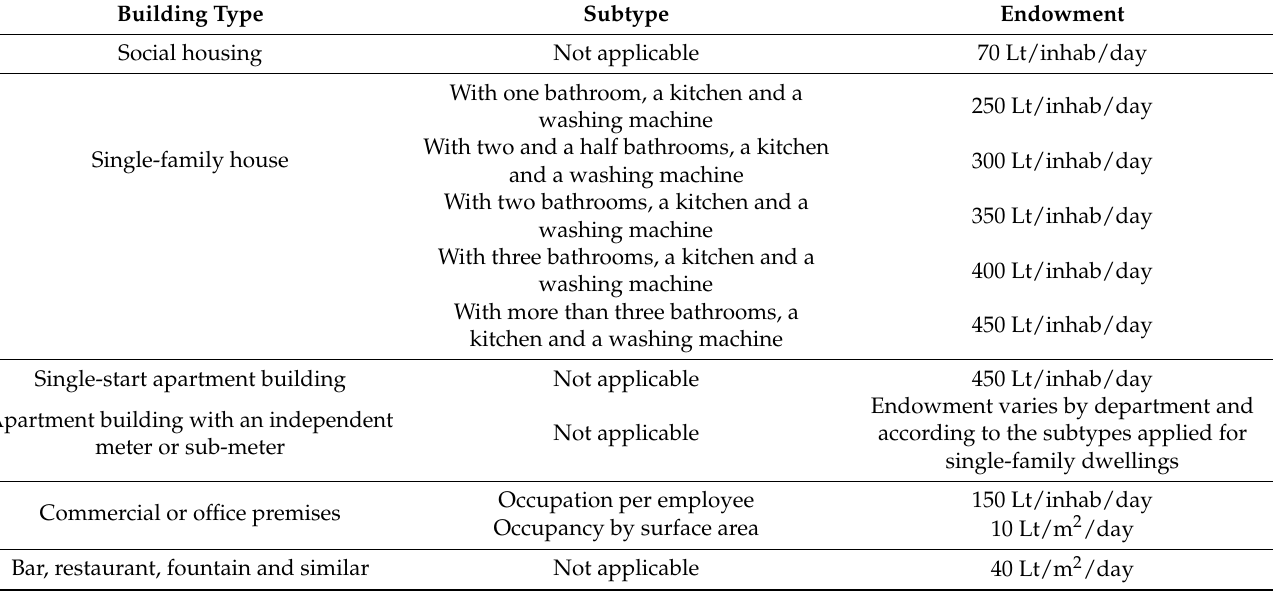
Table 3. Adapted supplies for automatic